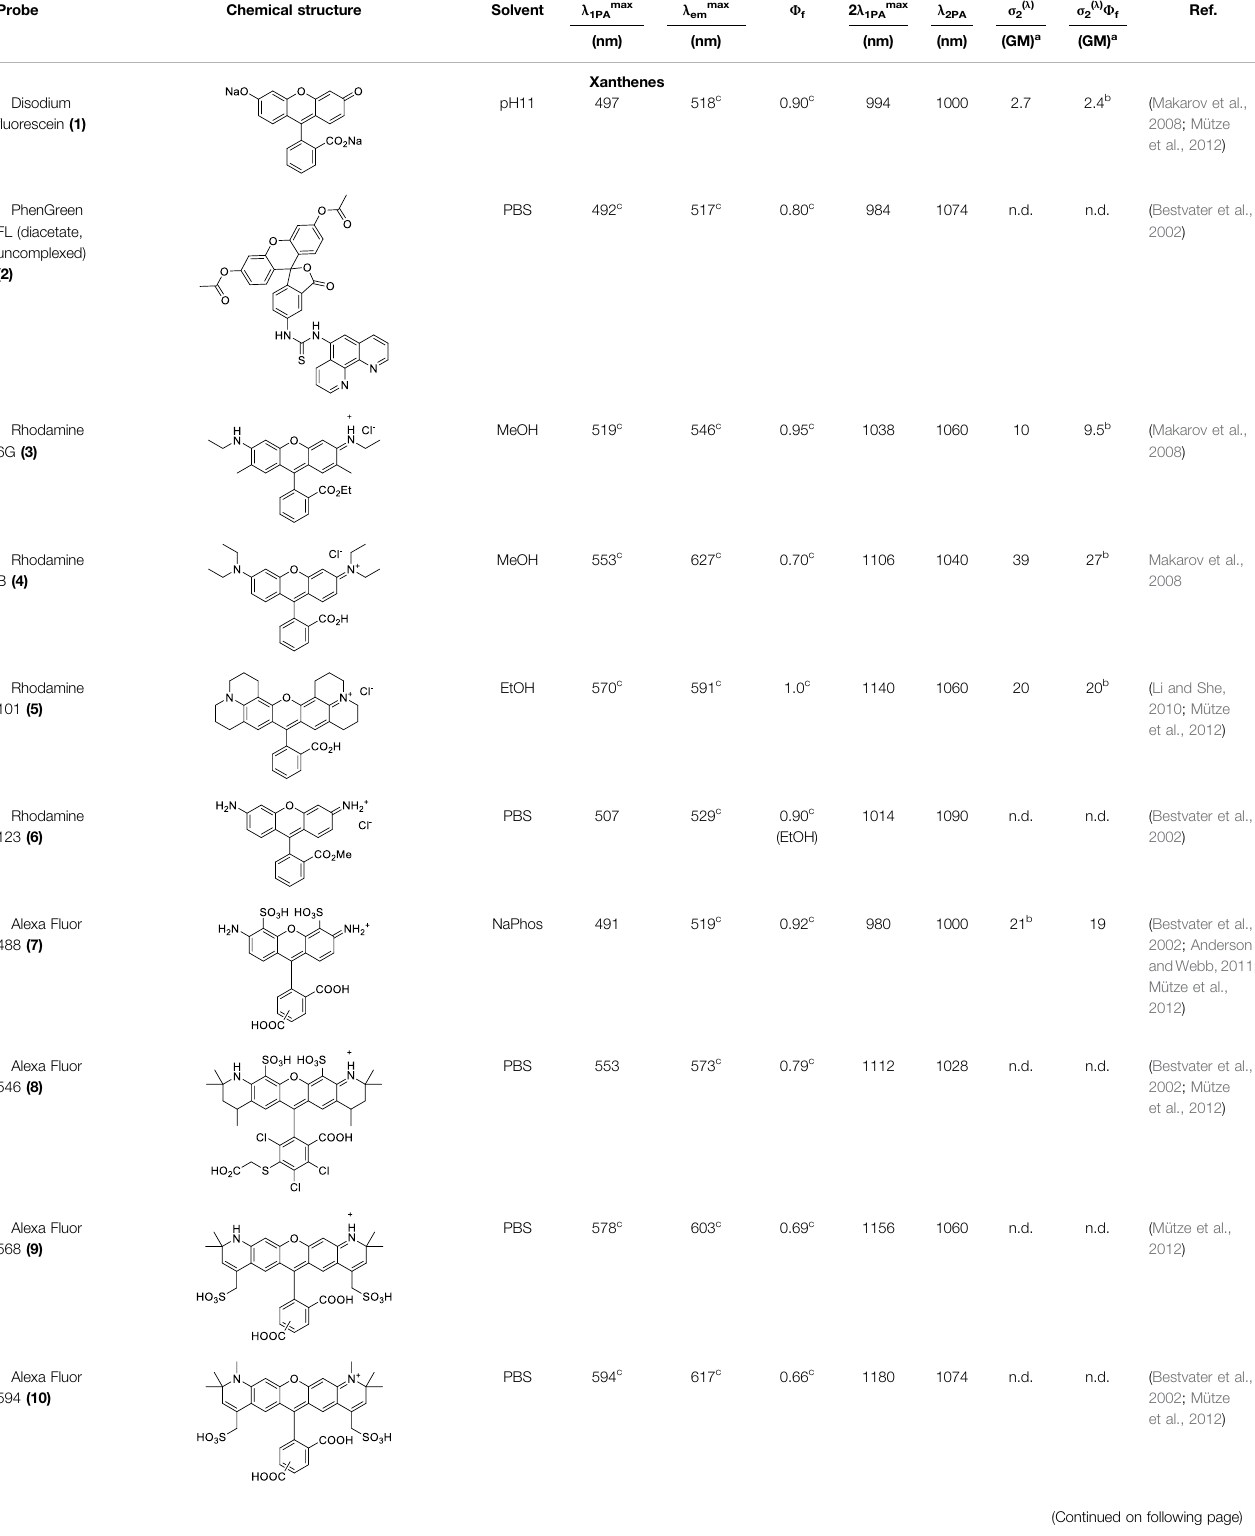
TABLE 1 | 1PA, 2PA and emission properties of NIR-II chromophores reported in literature. Solvent and method of 2P properties are also noted for comparison.